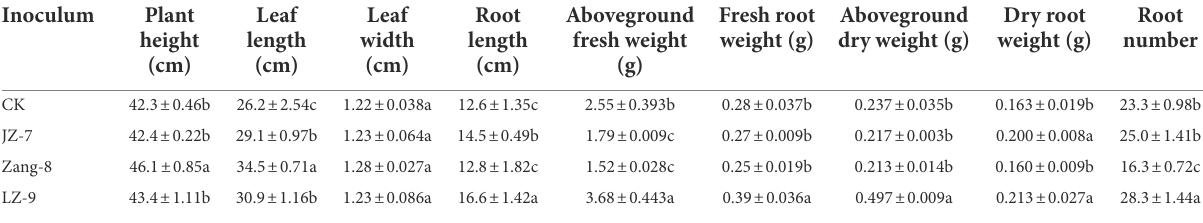
TABLE 2 The effects of highland barley (HB) seed endophyte isolates on the growth of HB seedlings. Inoculum